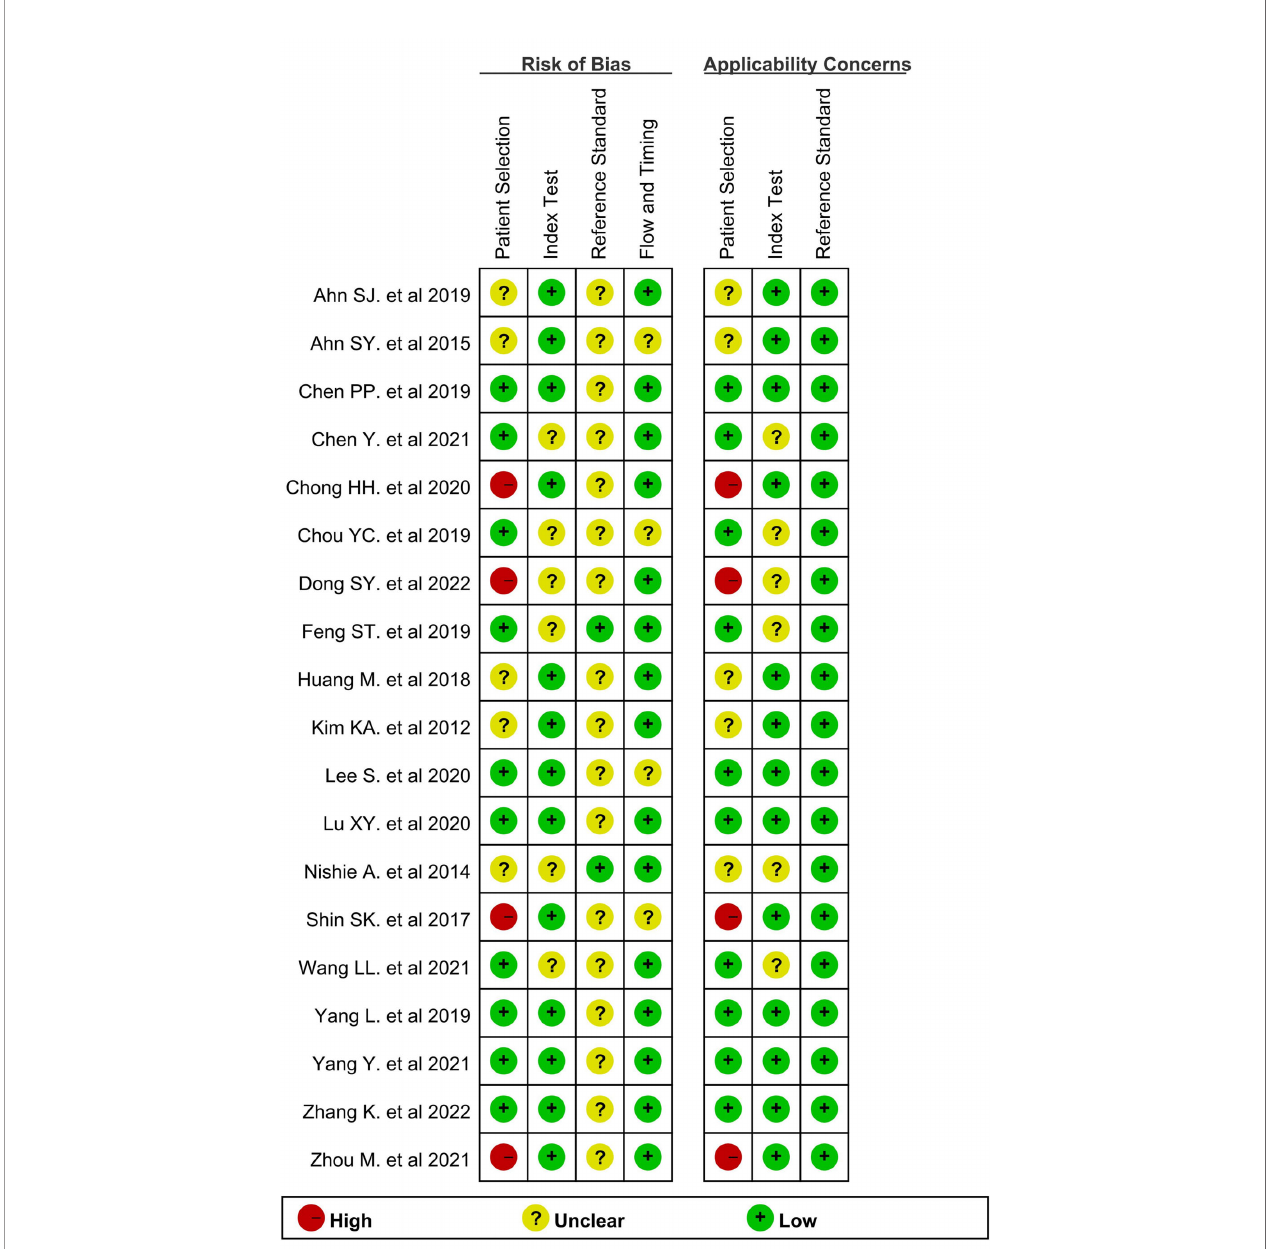
FIGURE 2 | Methodological quality summary of all included studies by using Quality Assessment of Diagnostic Accuracy